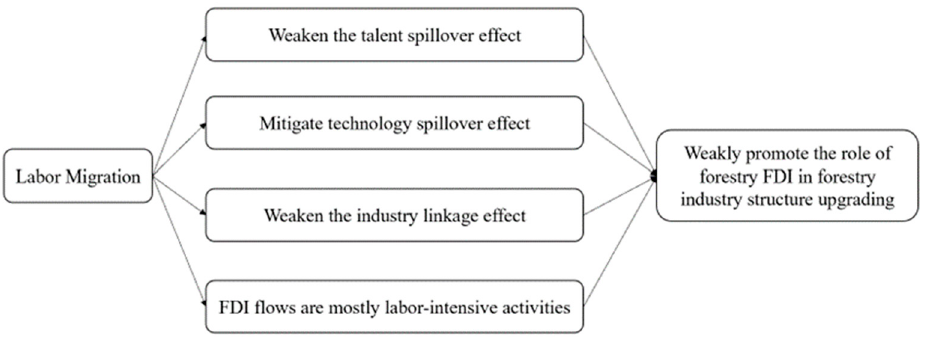
Figure 3. Possible impact paths of the moderating effect of labor migration.